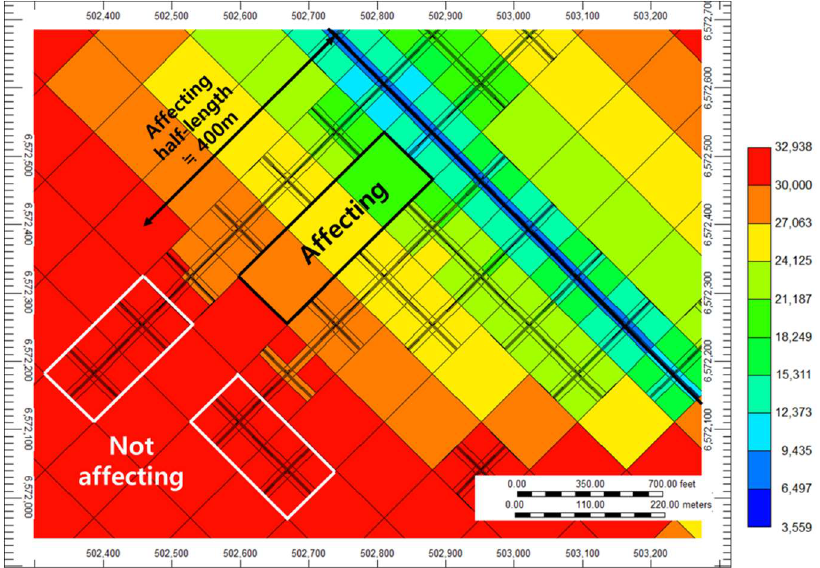
Figure 21. Map of pressure propagation after 20 years of production. (Colors of the grids indicate the kPa).